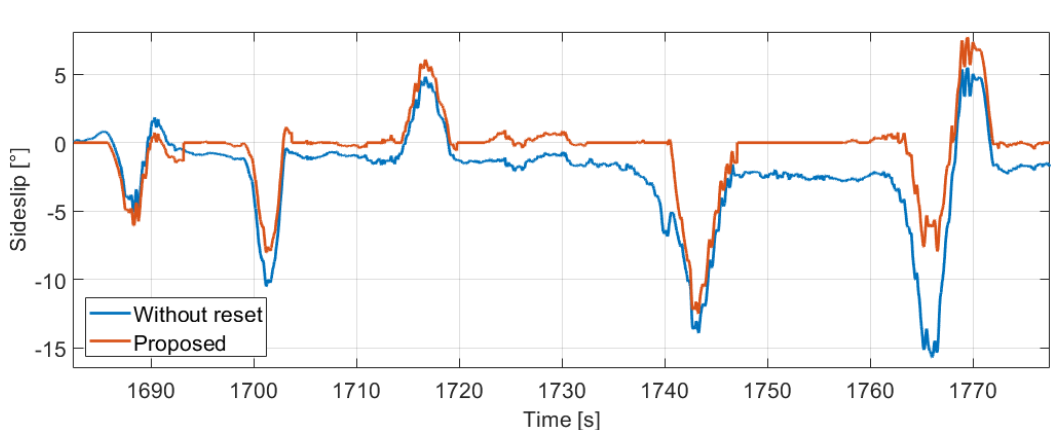
Figure 9. Estimated sideslip